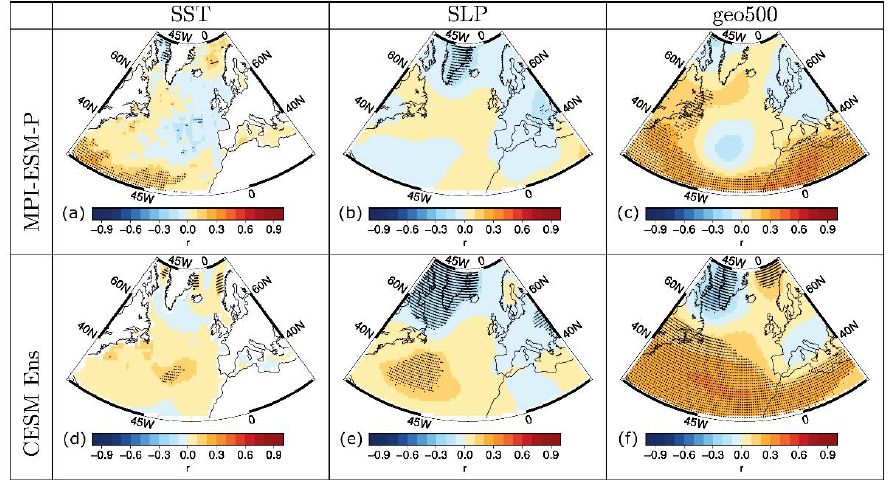
Figure 2. Correlation patterns between TSI and the SST ( a , d ), the SLP ( b , e ) and the geo500 ( c , f ) for the MPI-ESM-P ( a – c ) and CESM ensemble mean ( d – f ). The hatched areas indicate statistical significance at the 5% level. The range of r-values for SST, SLP and geo500 is approximately ±0.3, ±0.2, and ±0.4, respectively.